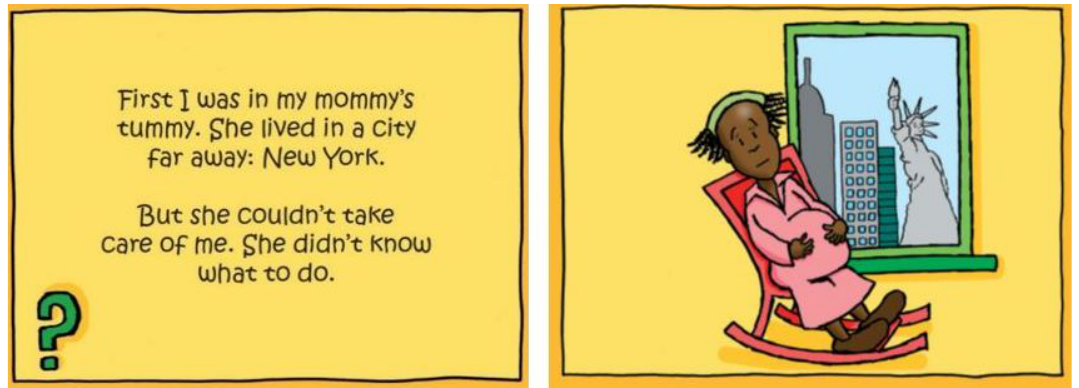
Figure 15. Arwen’s biological mother.